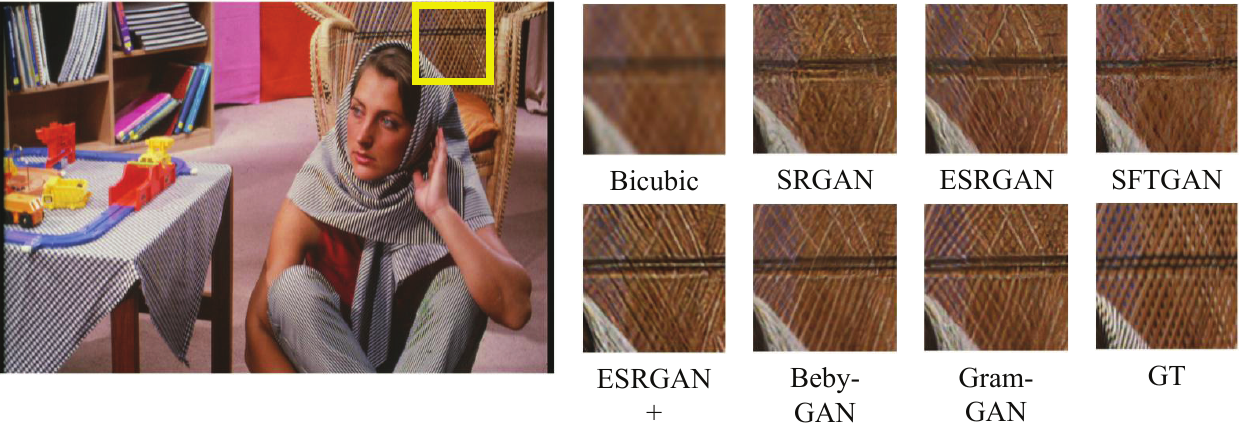
Figure 7. Visual evaluation of state-of-the-art perception-driven methods. Image “barbara” from